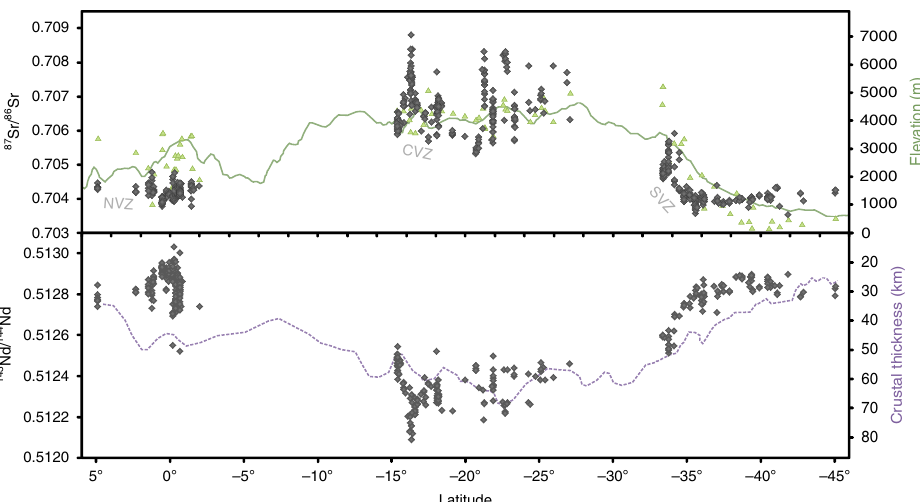
Fig. 3 Comparison of whole-rock 87 Sr/ 86 Sr and 143 Nd/ 144 Nd ratios of arc lavas with crustal thickness and elevation. Quaternary whole-rock Sr and Nd isotope ratios of frontal-arc lavas (diamonds, compilation from this study; see Methods and Supplementary Data 1) compared to volcano base elevation (triangles; this study, Methods, and refs. 69, 74 ), arc front mean elevation (100 km-wide swath, GTOPO30 digital elevation model (DEM) 75 ) and crustal thickness pro fi les ( fi ve period moving average, data from ref. 50 , RMS < 3.5 km)